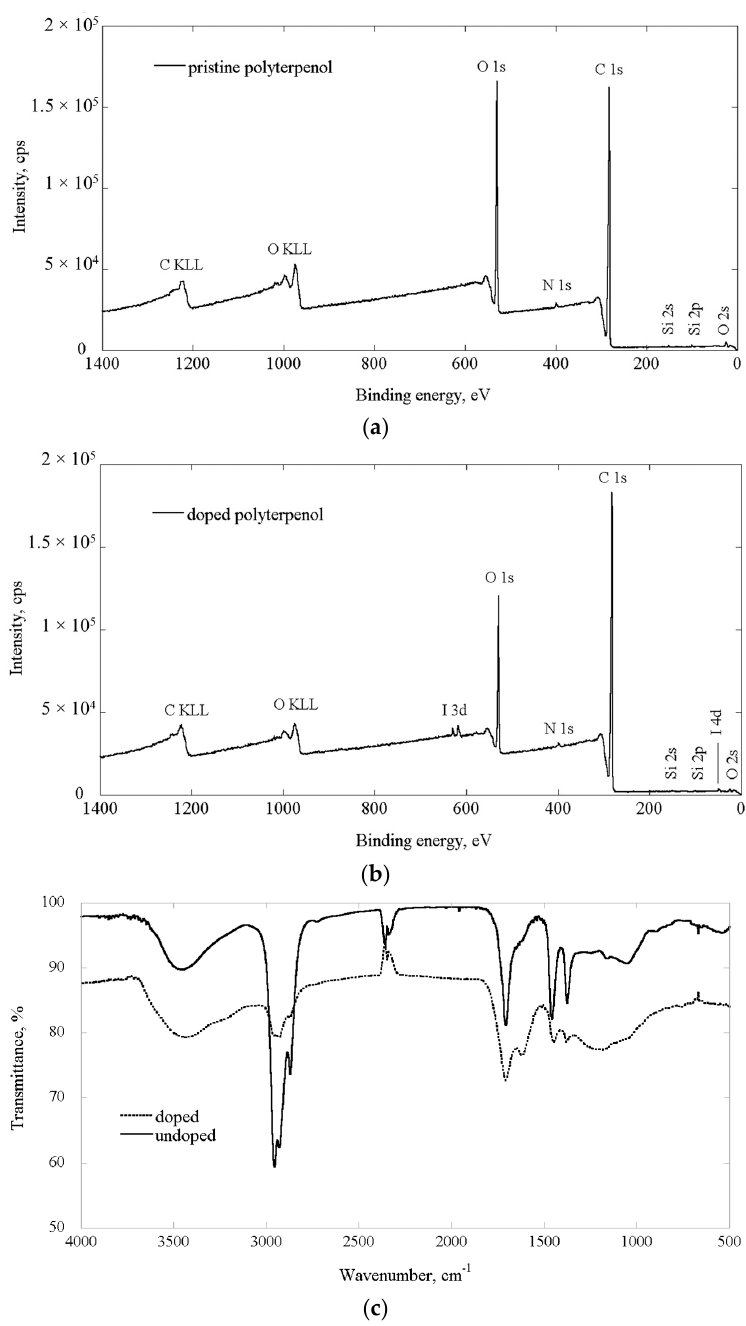
Figure 1. Chemical properties of pristine and iodine-doped polyterpenol samples: XPS spectra for pristine ( a ) and doped ( b ) samples; and ( c ) FTIR